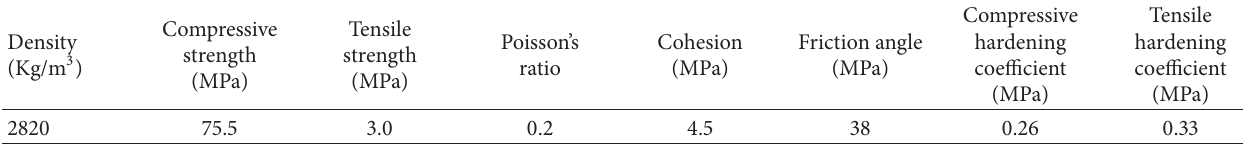
Table 3: Constitutive parameters of the rock.